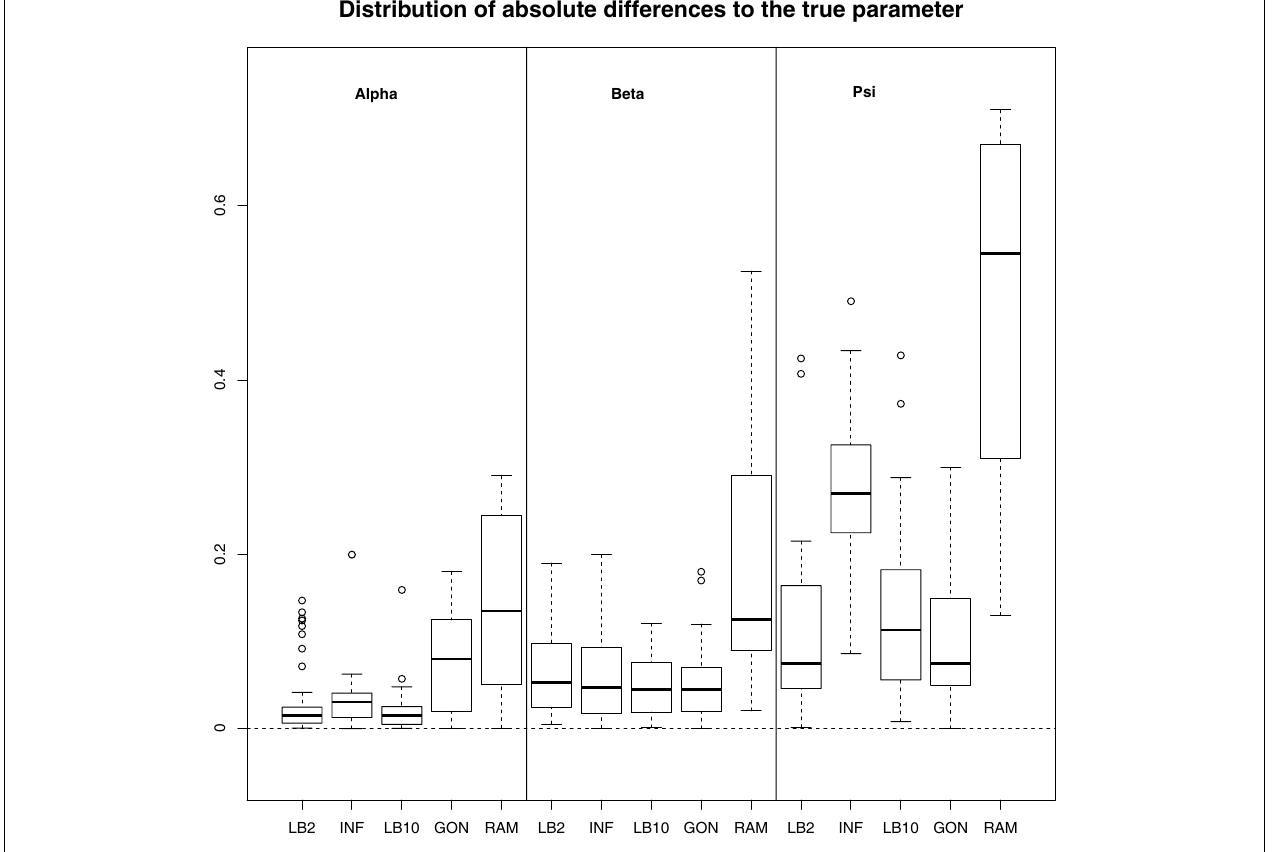
FIGURE 7 | Boxplots of the distributions of the absolute differences of an estimate to the true parameter over 50 datasets . The three sections from left to right represent the parameters α , β , and ψ from equation (62). Within each section, the boxplots from left to right are: LB2 method, INF method, LB10 method, GON’s method [boxplot reconstructed from González et al. (2013)], and RAM’s method [boxplot reconstructed from González et al. (2013)]. For an explanation of the boxplot form, see the beginning of Section 6. Figure reconstructed from Macdonald and Husmeier (2015).